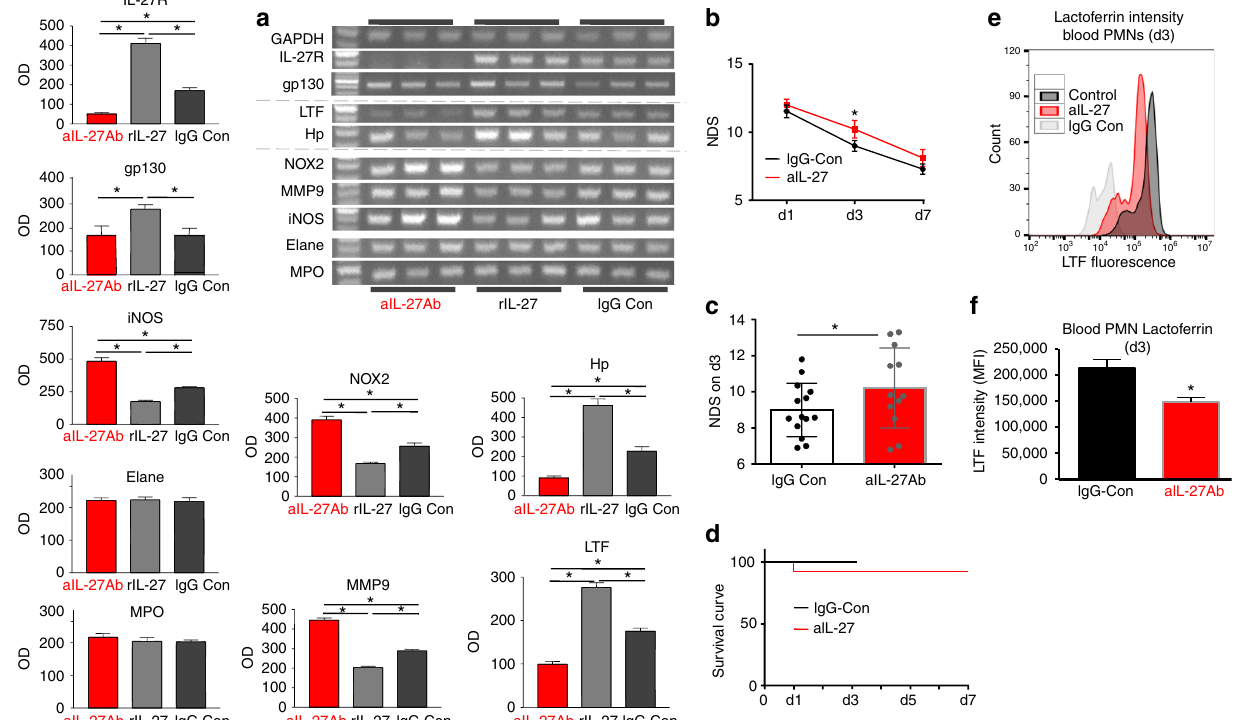
Fig. 3 IL-27 neutralization in C57BJ6 mice alters gene expression in BM-PMNs and aggravates neurological outcome after ICH. a Photograph of representative gels (RT-PCR) and bar graphs demonstrating the expression pro fi le of indicated genes in the BM-PMNs, puri fi ed from mice at 48 h after ICH that were treated with either mouse anti-IL-27 antibody ( α IL-27Ab, 40 μ g/mouse), recombinant mouse IL-27 (rIL-27; 50 ng/kg), or rat IgG isotype control antibody (40 μ g/mouse), all by i.v. injection at 0.5, 24, and 42 h after ICH. Data are expressed as mean ± SEM ( n = 5). * p ≤ 0.05, established using one-way ANOVA followed by Newman – Keuls post-test. b The NDS in mice treated with anti-IL-27 antibody ( α IL-27Ab) and rat IgG isotype control (IgG Cont) at days 1, 3, and 7 after ICH. The grand NDS is a composite score from four behavioral tests (Footfault, Postural Flexing, Wire, and Circling). * p < 0.05, established using one-way ANOVA followed by Newman – Keuls post-test. c Bar graph of the NDS on day 3 from the above study. In b , c , the data were expressed as mean ± SEM ( n = 12). * p < 0.05, compared with the control, established using paired t -test. d Survival curve of day 1 – day 7 after ICH in the above study in b . There is no difference between the groups. e , f Flow cytometry of peripheral blood taken from animals treated with anti-IL-27 antibody ( α IL-27) or isotype control IgG (IgG Con) at three days post-ICH and stained for LTF. Data presented as MFI and given as mean +/ − SEM ( n = 3/group), established using paired t -test. An isotype control antibody (IgG Con) was used to determine the negative and